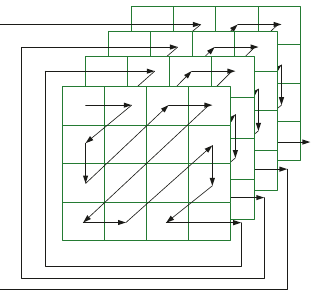
Figure 5: An illustration of zigzag.